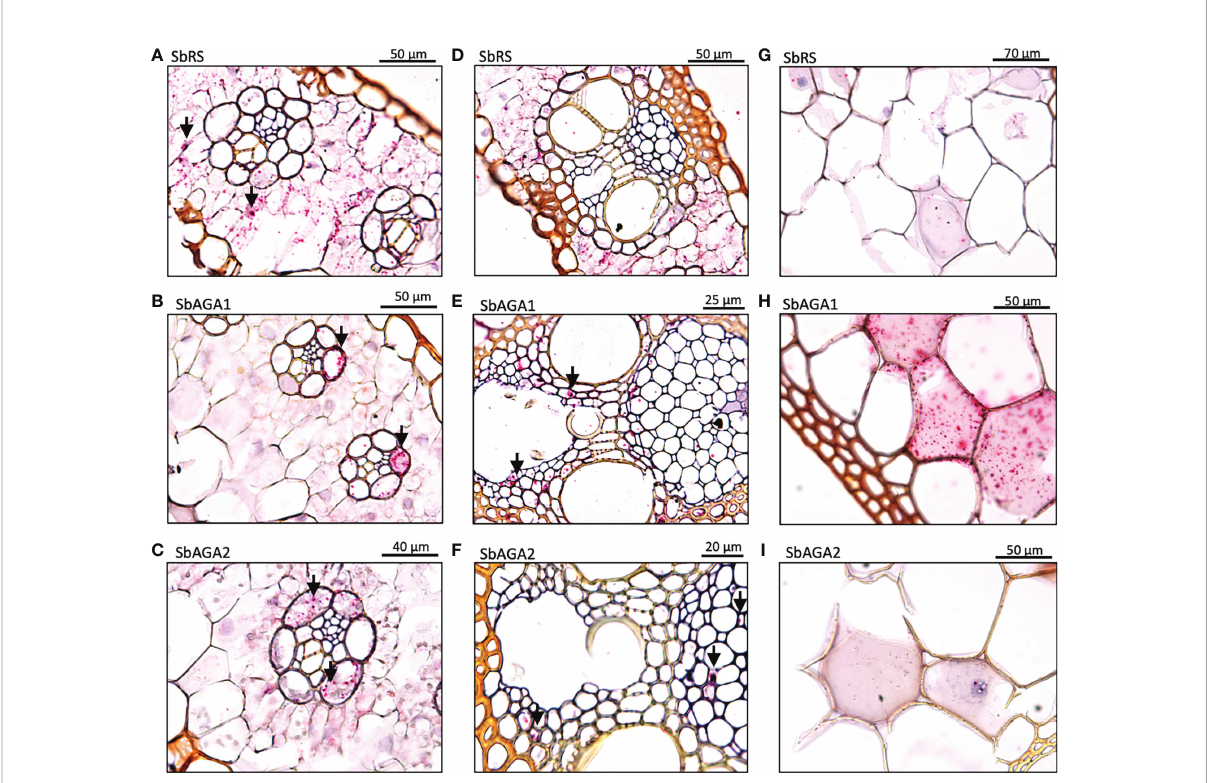
FIGURE 8 In situ localization of SbRS, SbAGA1 , and SbAGA2 transcripts in Della leaves. Red punctate structures indicate the location of transcripts. Black arrows represent points of notable localization signals. 40X objective. (A-C) show RFO pathway expression in minor veins of the leaf. (D-F) show RFO pathway expression in major veins of the leaf. (G-I) show RFO pathway expression in parenchyma cells of the midrib of the